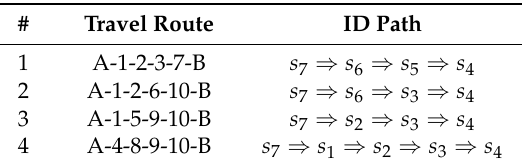
Table 2. The convergence of the golden selection method in the last three steps.